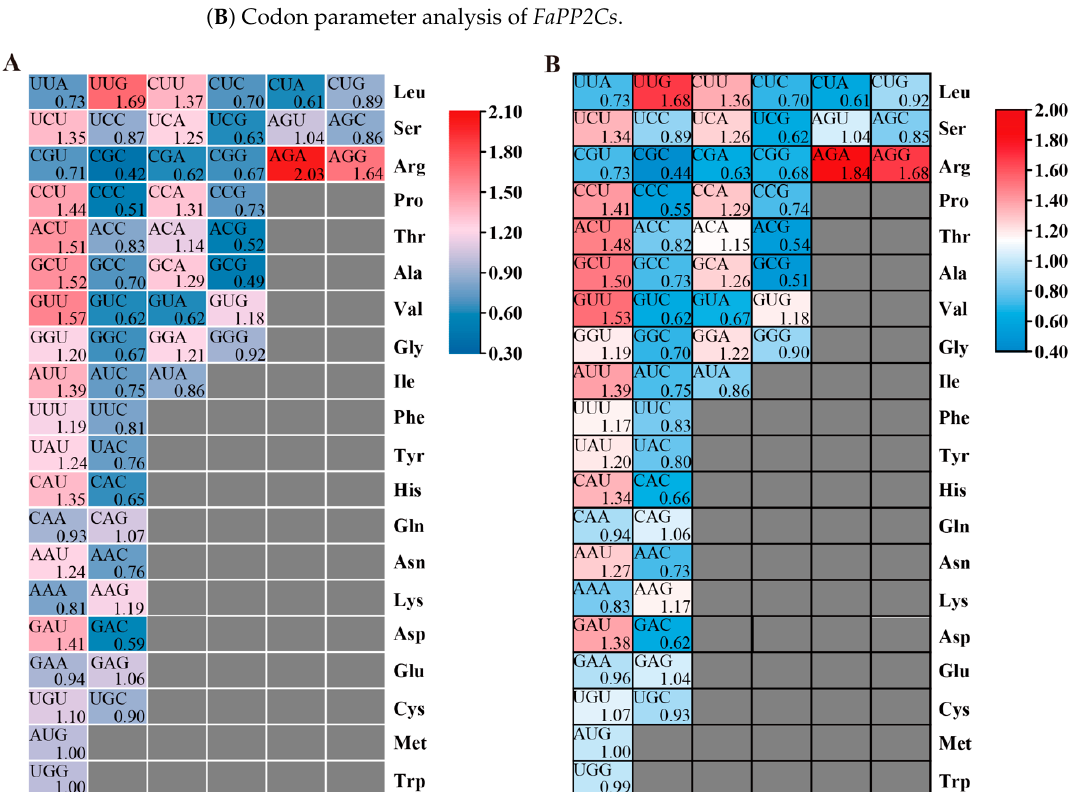
Figure 6. The relative synonymous codon usage (RSCU) analysis of the PP2C gene family in wood- land strawberry and pineapple strawberry. Note: A color gradient mapped from low (blue) to high (red) indicates an increase in RSCU. ( A ) The RSCU analysis of the FvPP2C gene family. ( B ) The RSCU analysis of the FaPP2C gene family.